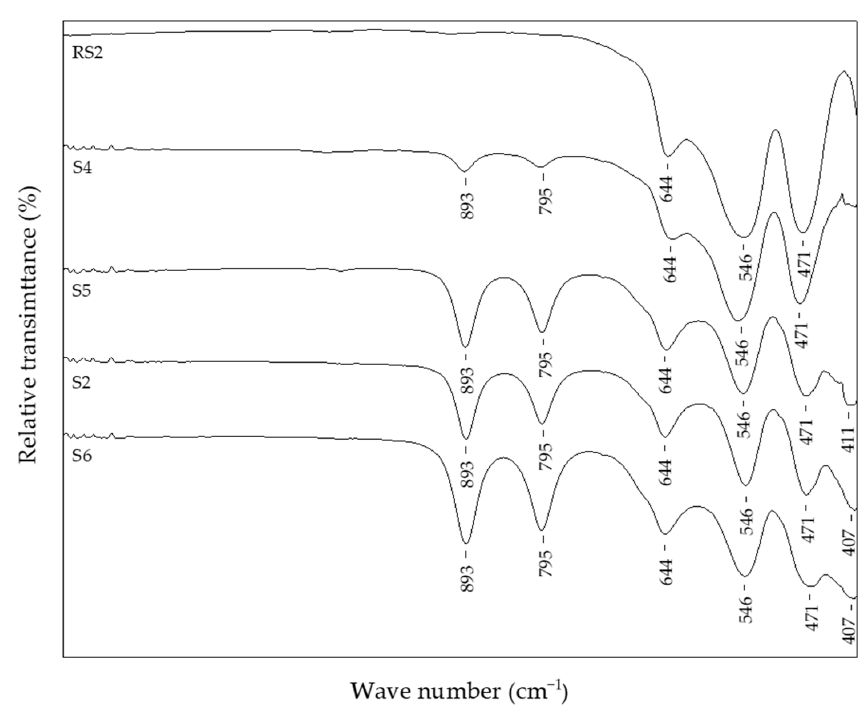
Figure 5. FT-IR spectra of samples with different percentages of CTAB in precipitation mixture.